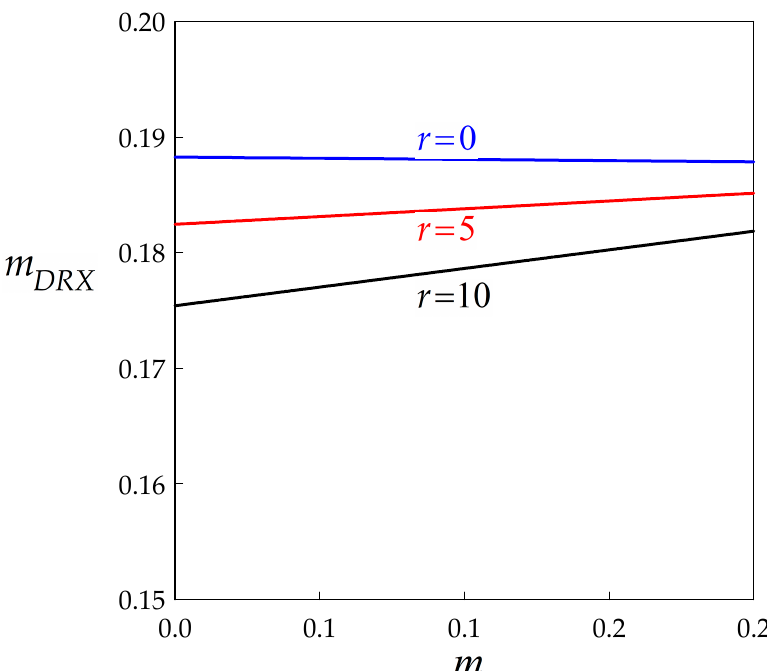
Figure 8. Influence of the microscopic strain rate sensitivity m on its macroscopic counterpart m DRX for three values of the dynamic recovery parameter.